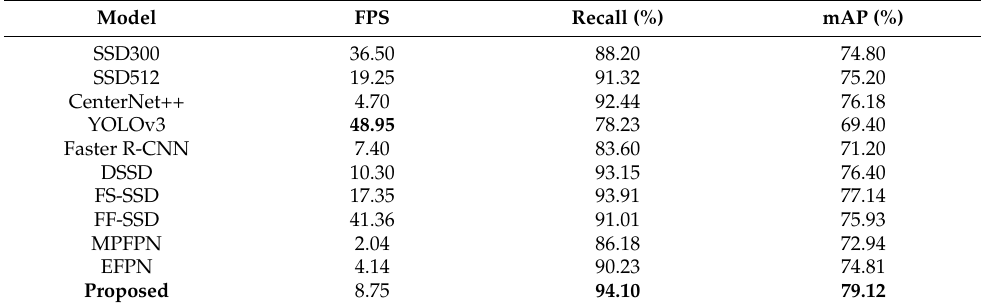
Table 2. The mAP, Recall, and FPS comparison of the proposed model with the state-of-the-art small object detectors on our custom livestock dataset. Some of the general purpose object detectors have been included in this